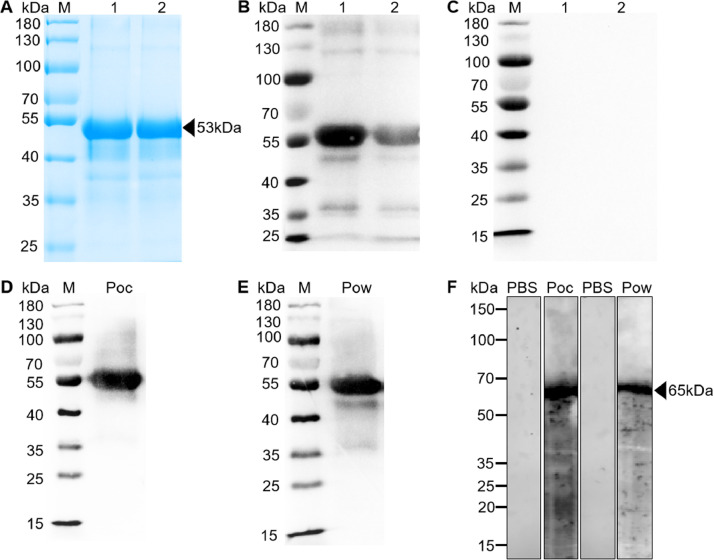
RPoAMA-1 protein expression and anti-rPoAMA-1 antibody detected in rPoAMA-1-immunized mice by SDS-PAGE. (A) Purified rPoAMA-1 (~53 kDa) was resolved by 8% SDS-PAGE. M: protein marker, 1: purified rPocAMA-1, 2: purified rPowAMA-1. (B) Western blot analysis of rPoAMA-1 using anti-His-antibody. M: protein marker, 1: purified rPocAMA-1, 2: purified rPowAMA-1. (C) Western blot analysis of rPocAMA-1 using PBS-immune, rPocAMA-1-immune and rPowAMA-1-immune mouse sera. (D) Western blot showing recognition of native PoAMA-1 antigen in crude proteins from parasite lysate by mouse anti-rPoAMA-1 antibodies (~65 kDa). Arrowheads indicate bands specific to each recombinant protein.